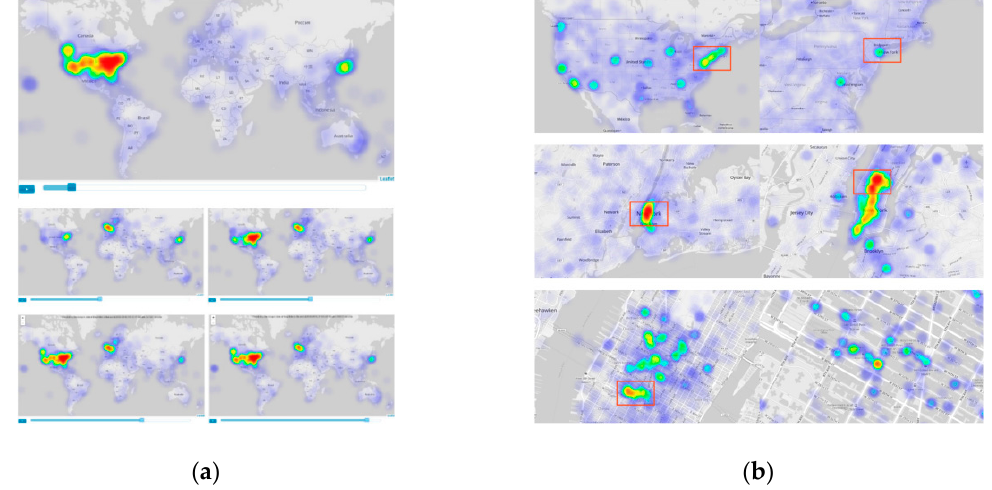
Figure 18. Example of interactive heatmap visualization using: ( a ) stream player; and ( b ) hierarchical interactive visualization [52].